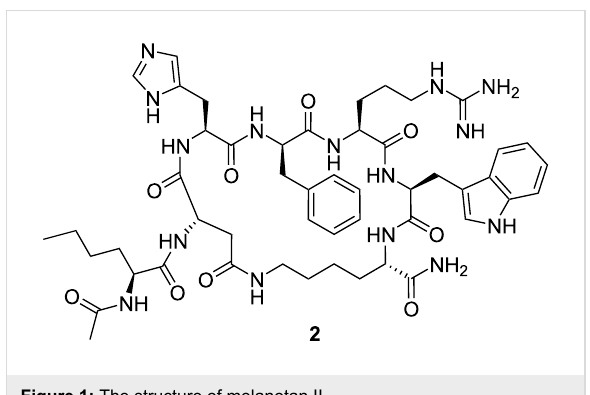
Figure 1: The structure of melanotan